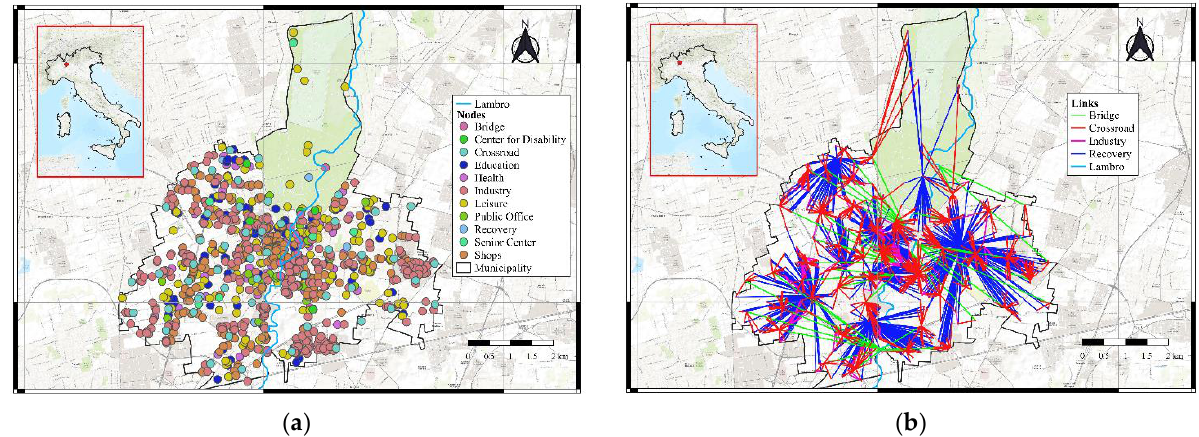
Figure 2. Map of providers and services exchange, the connections from providers to residential are removed for readability: ( a ) nodes and ( b ) links.